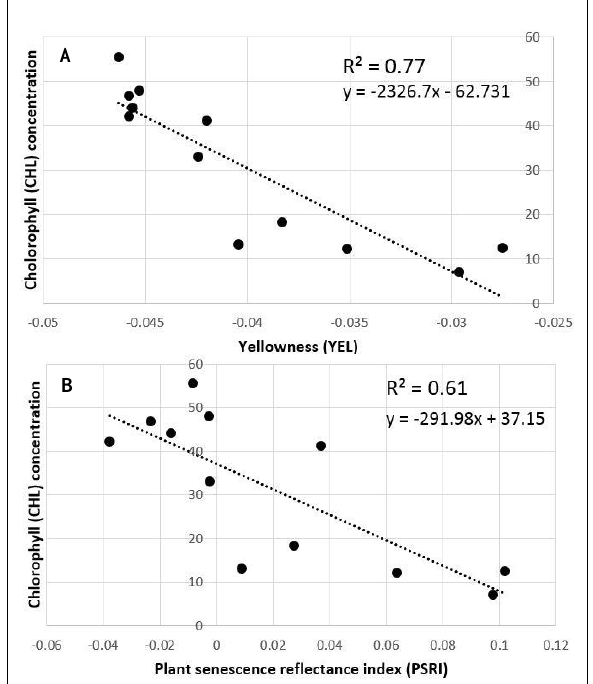
Figure 3. Linear regression of YEL (A) and PSRI (B) to Chl measurements at sample site